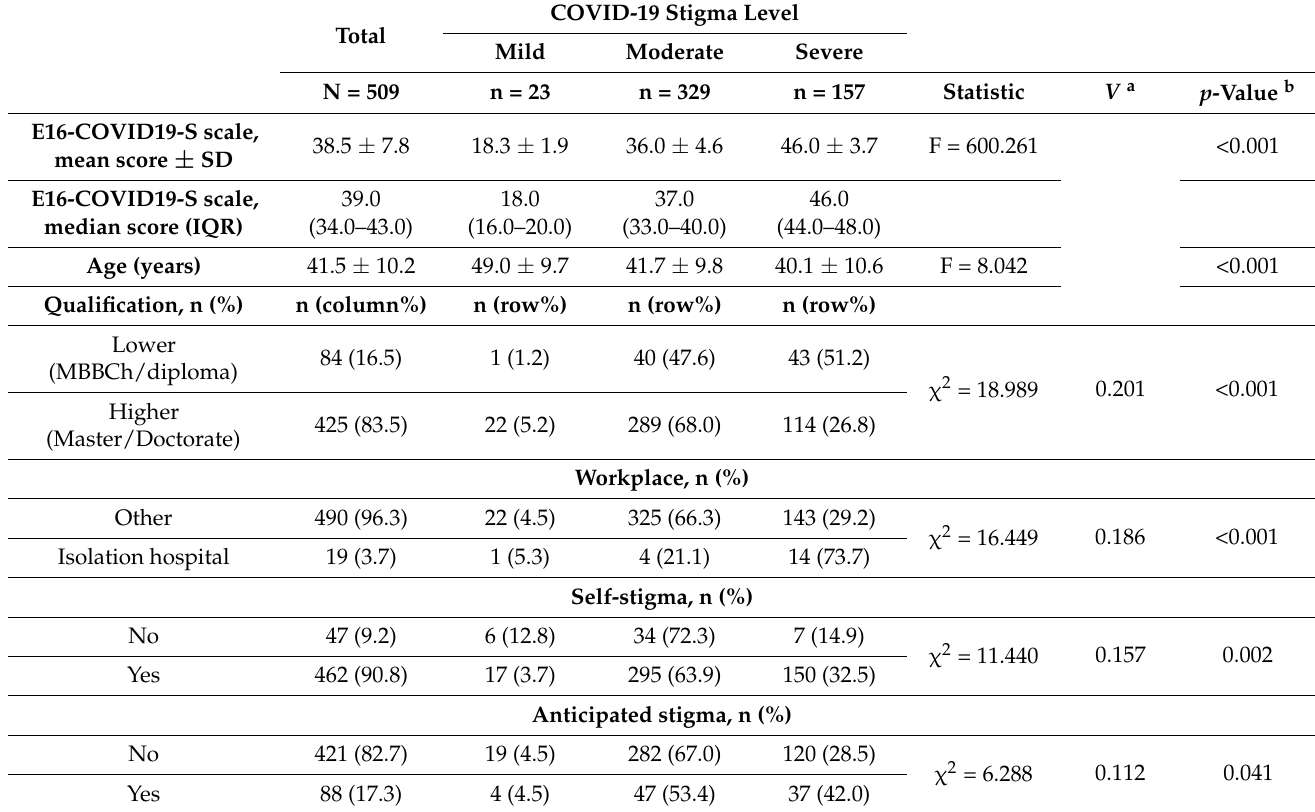
Table 4. The E16-COVID19-S scale score, levels, and associated factors for assessment of construct validity (N = 509). COVID-19 Stigma Level Total